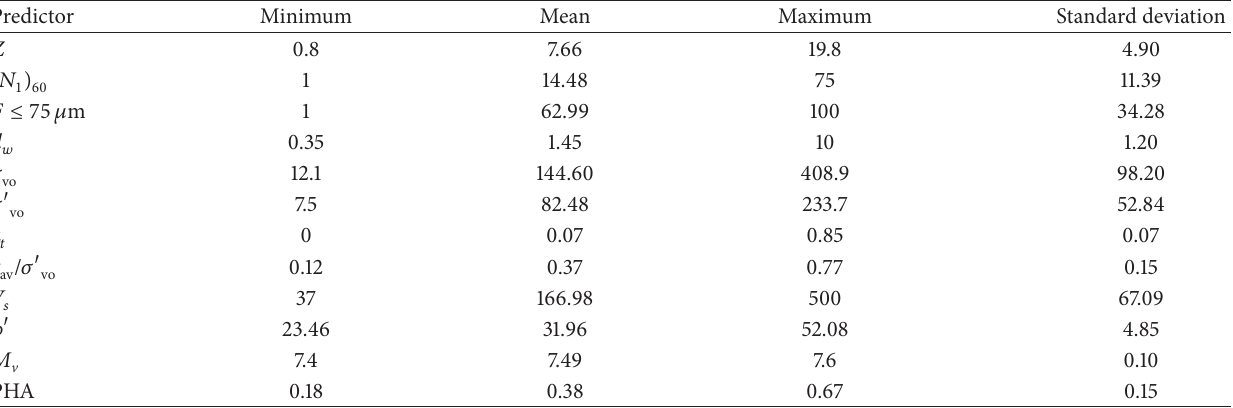
Table 2: Descriptive statistics of variables used in the model development.